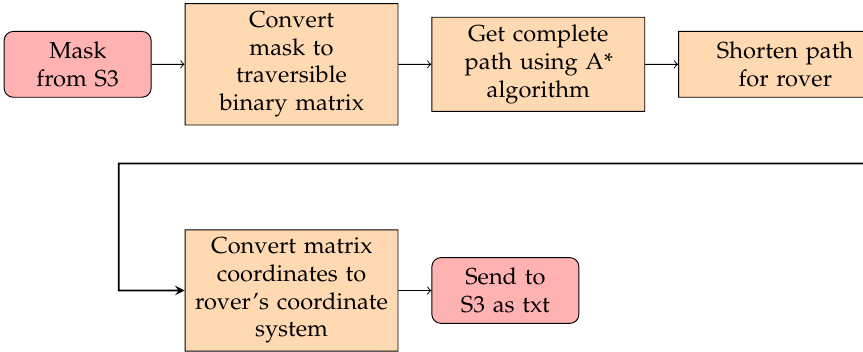
Figure 6. Procedure to obtain rover